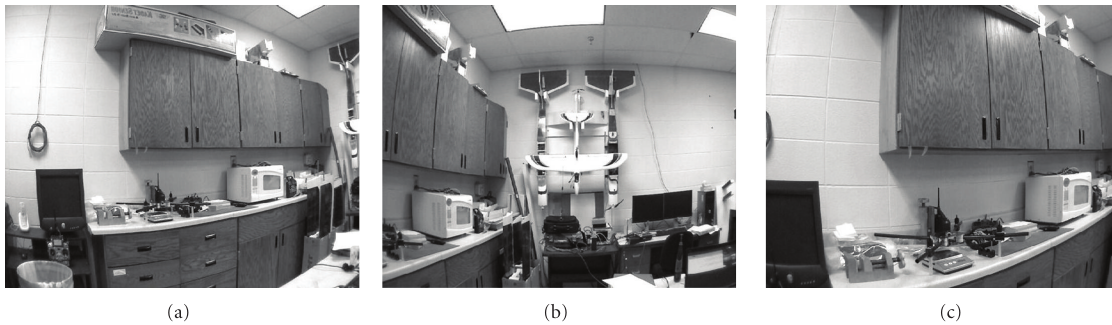
Figure 3: Example of matching a newly added keyframe. From left to right: newly added keyframe, PTAMM match for a new keyframe, proposed FAST-based match. For the new method, note the overlap of the left parts of the keyframes which allows for addition of new 3D features to the scene. Using original PTAMM match would not initialize new features.